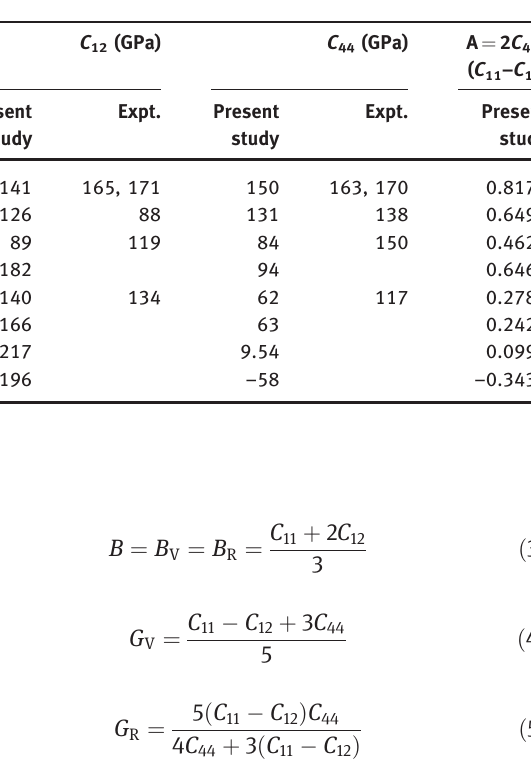
Table 3: Calculated bulk modulus ( K ), elastic constants and anisotropy ( A ) of metal nitrides TmN (Tm ¼ Ti, Zr, Hf, V, Nb, Ta, Cr, Mo) and available experimental data [22 –